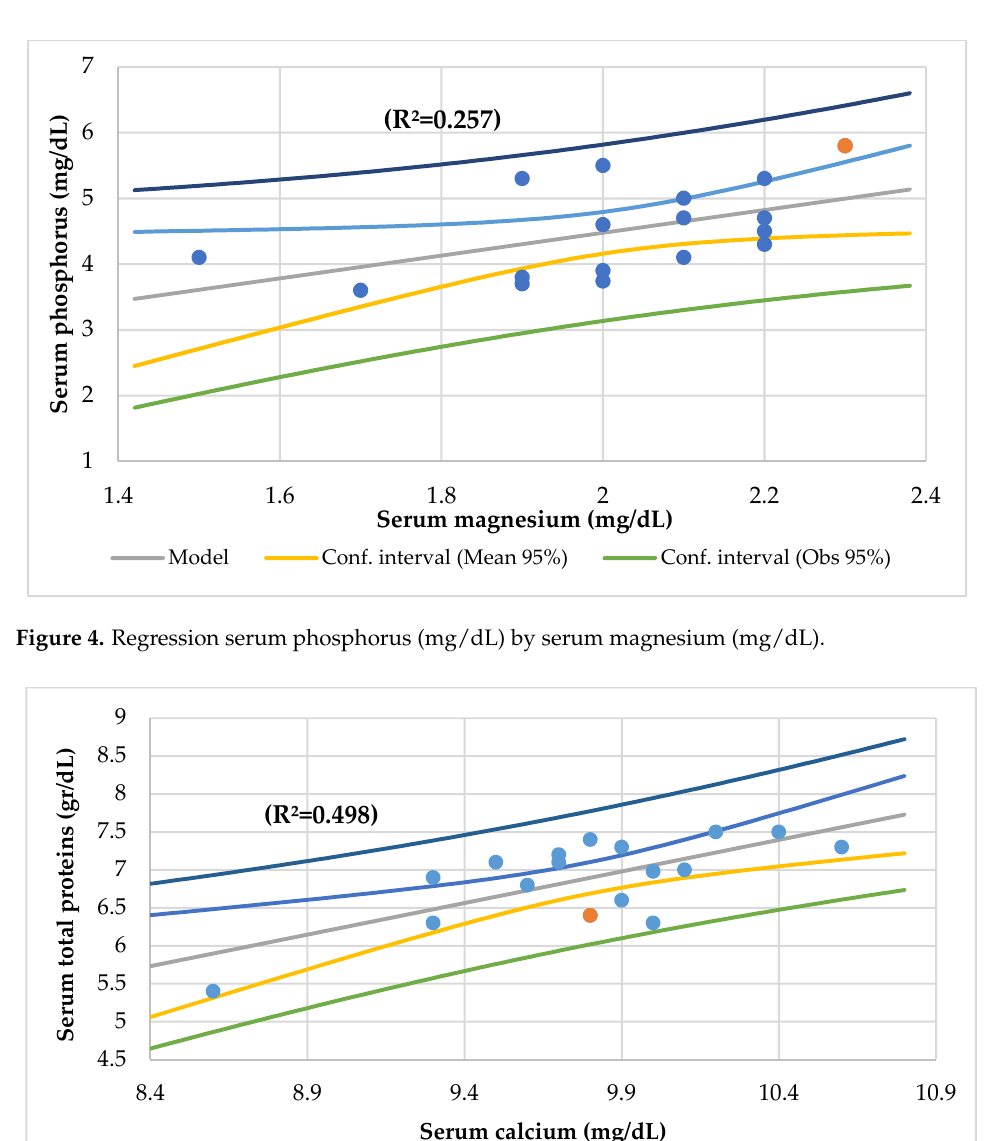
Figure 3. Regression height-for-age Z-score by magnesium intake (%Dietary Reference Intake).